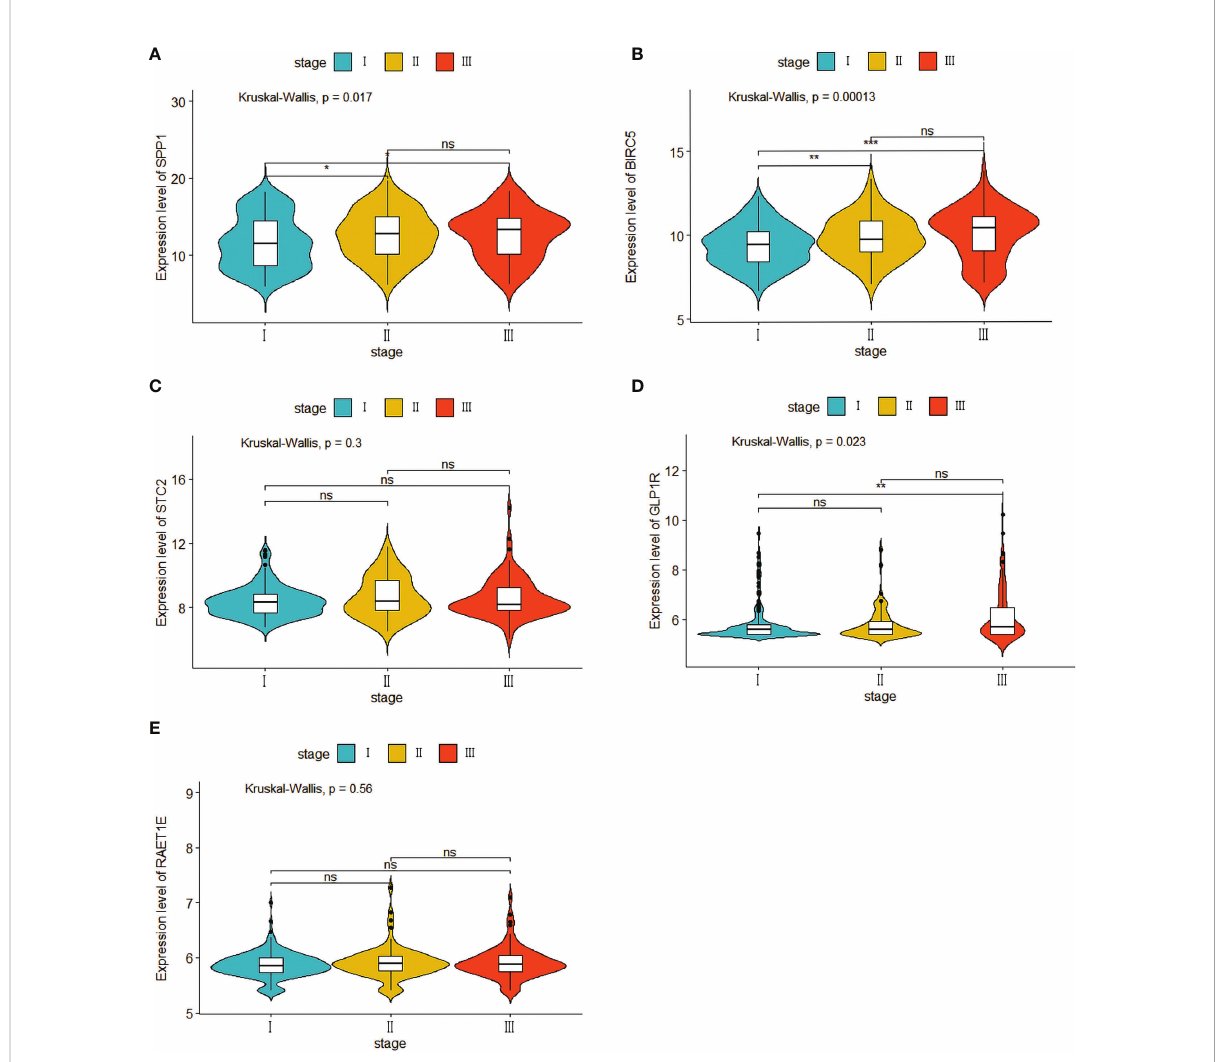
FIGURE 7 Five IRGs mRNA expression in different pathological T stage in the TCGA cohort. (A) the expression of SPP1. (B) the expression of BIRC5. (C) the expression of STC2. (D) the expression of GLP1R. (E) the expression of ARET1E. *p<0.05; ** p<0.01; *** p<0.001; ns, not